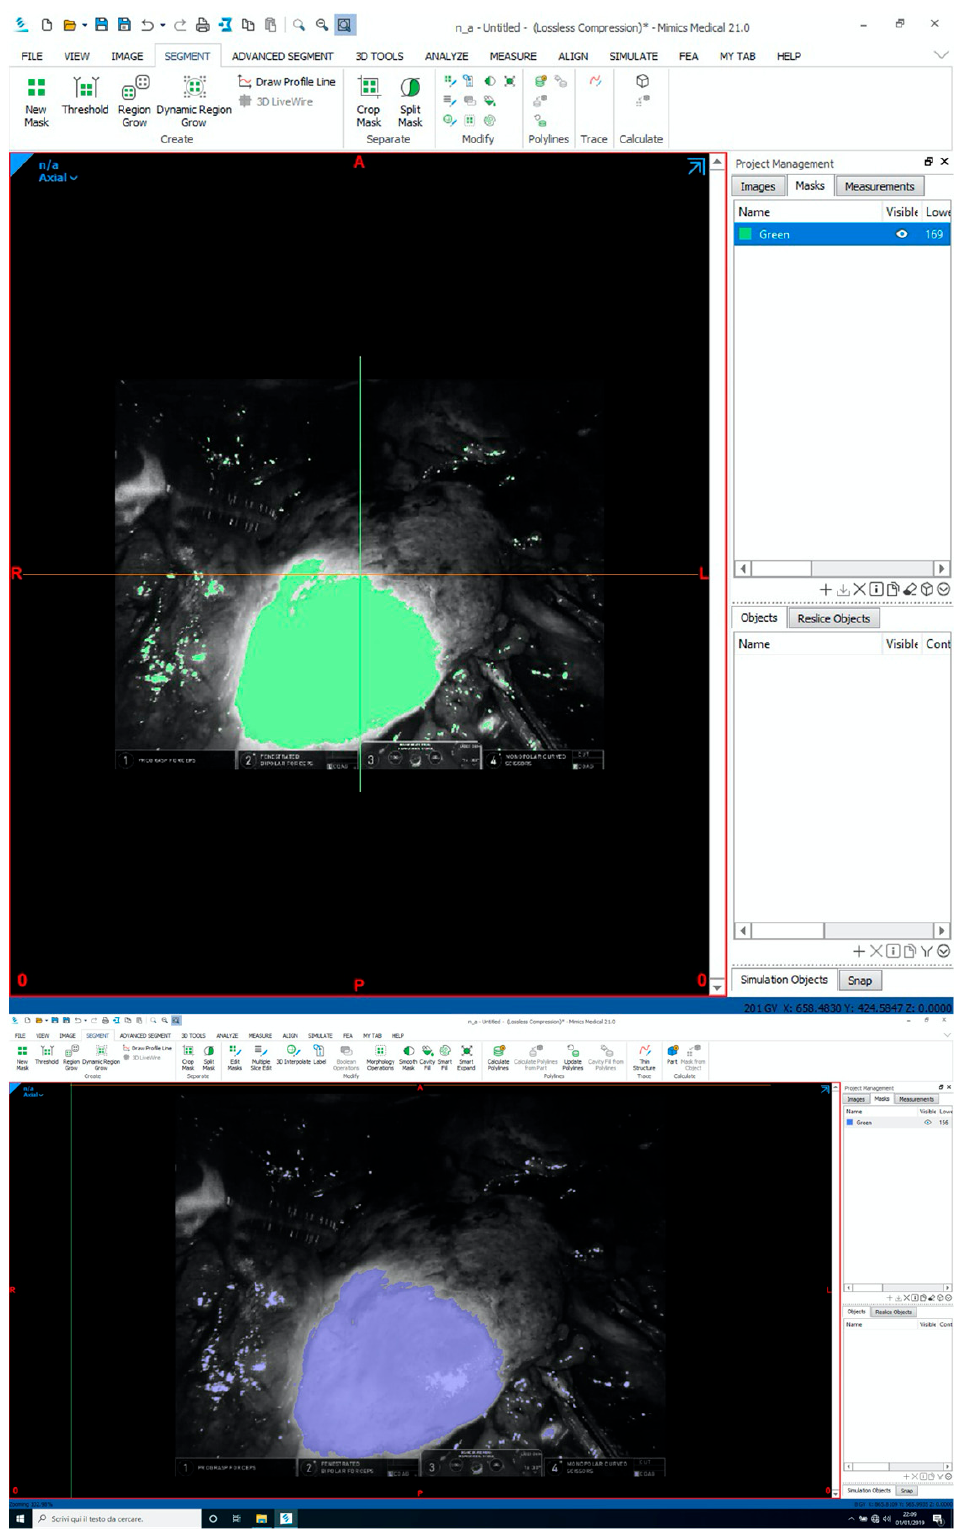
Figure 3. Using Mimics 21.0 (Materialise, Leuven, Belgium), it is possible to calculate the concordance between 3DVM regions and reality, measuring the extension of the 3DVM areas overlaid on the intraoperative stream and comparing them with the ICG-enhanced area, perceived as a group of pixels of the same color, from the recorded surgical image.